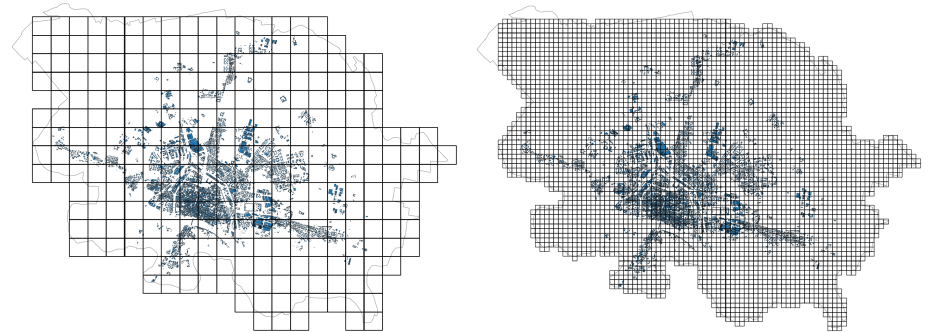
Figure 10. Grids with resolutions of 500m × 500m (left) and 125m × 125m (right).